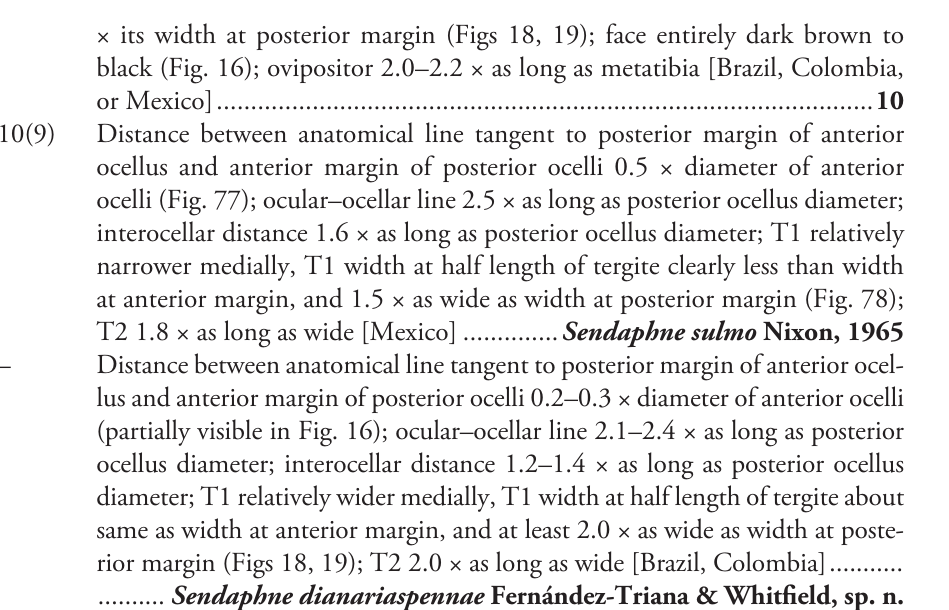
Taxonomic treatment of species, in alphabetical order Sendaphne anitae Fernández-Triana & Whitfield, sp. n. http://zoobank.org/5A29AD35-D955-44B1-B1C3-64182FD0E55B Figs 1–7 Holotype. Female, CNC. ECUADOR, Napo, Reventador; 11.iii.1983; coll. L. Hug- gert. DNA Voucher code: CNCHYM 07027. Paratypes. 4 ♀ (CNC), same locality and collecting date than holotype. Two of the specimens also have DNA Voucher codes: CNCHYM 07026, CNCHYM 07028. Diagnosis. This species is morphological similar to Sendaphne dianariaspennae and S . sulmo but differs from those species in the shape and angle of junction of veins r and 2RS, shape of mediotergite 2, ovipositor length, and head coloration (orange- yellow on clypeus and face centrally in anitae , head entirely dark brown to black in dianariaspennae and sulmo ). Description. Head color: dark brown to black, except for orange-yellow on cl- ypeus and face centrally. Mesosoma color: orange-yellow. Tegula color: orange-yellow. Metasoma color (dorsally): yellow. Metacoxa color: yellow. Anatomical line tangent to posterior margin of anterior ocellus crossing very slightly (less than 0.01 mm) above anterior margin of posterior ocelli. Ocular–ocellar line: 0.20 mm. Interocellar dis- tance: 0.09 mm. Posterior ocellus diameter: 0.09 mm. Body length: 4.0–4.5 mm. Fore wing length: 3.6–4.1 mm. Ovipositor length: 2.4–2.6 mm. Metacoxa length: 1.3 mm. Metafemur length: 1.2 mm. Metatibia length: 1.3–1.4 mm. T1 length/width